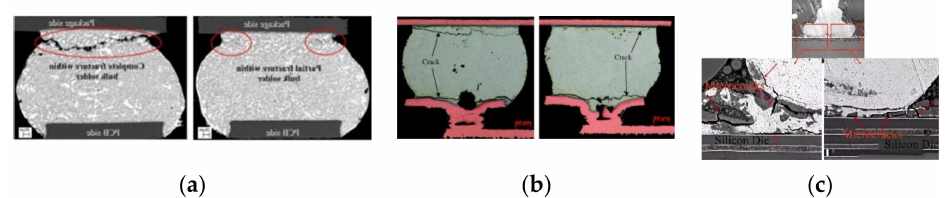
Figure 2. Failure of the solder joints of the BGA chips under the influences of ( a ) temperature, ( b ) vibration, and ( c )